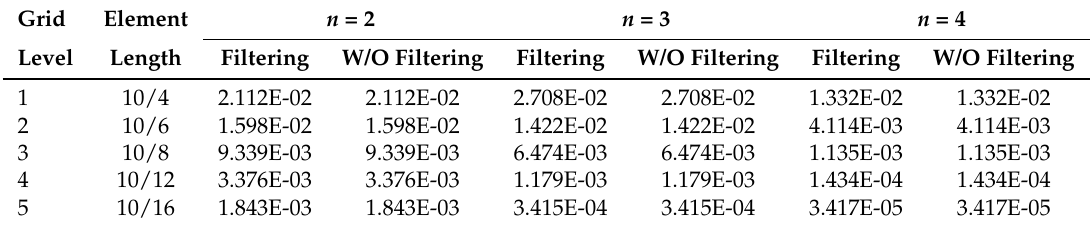
Table 1. L 2 error of density on unstructured grids with triangular elements.